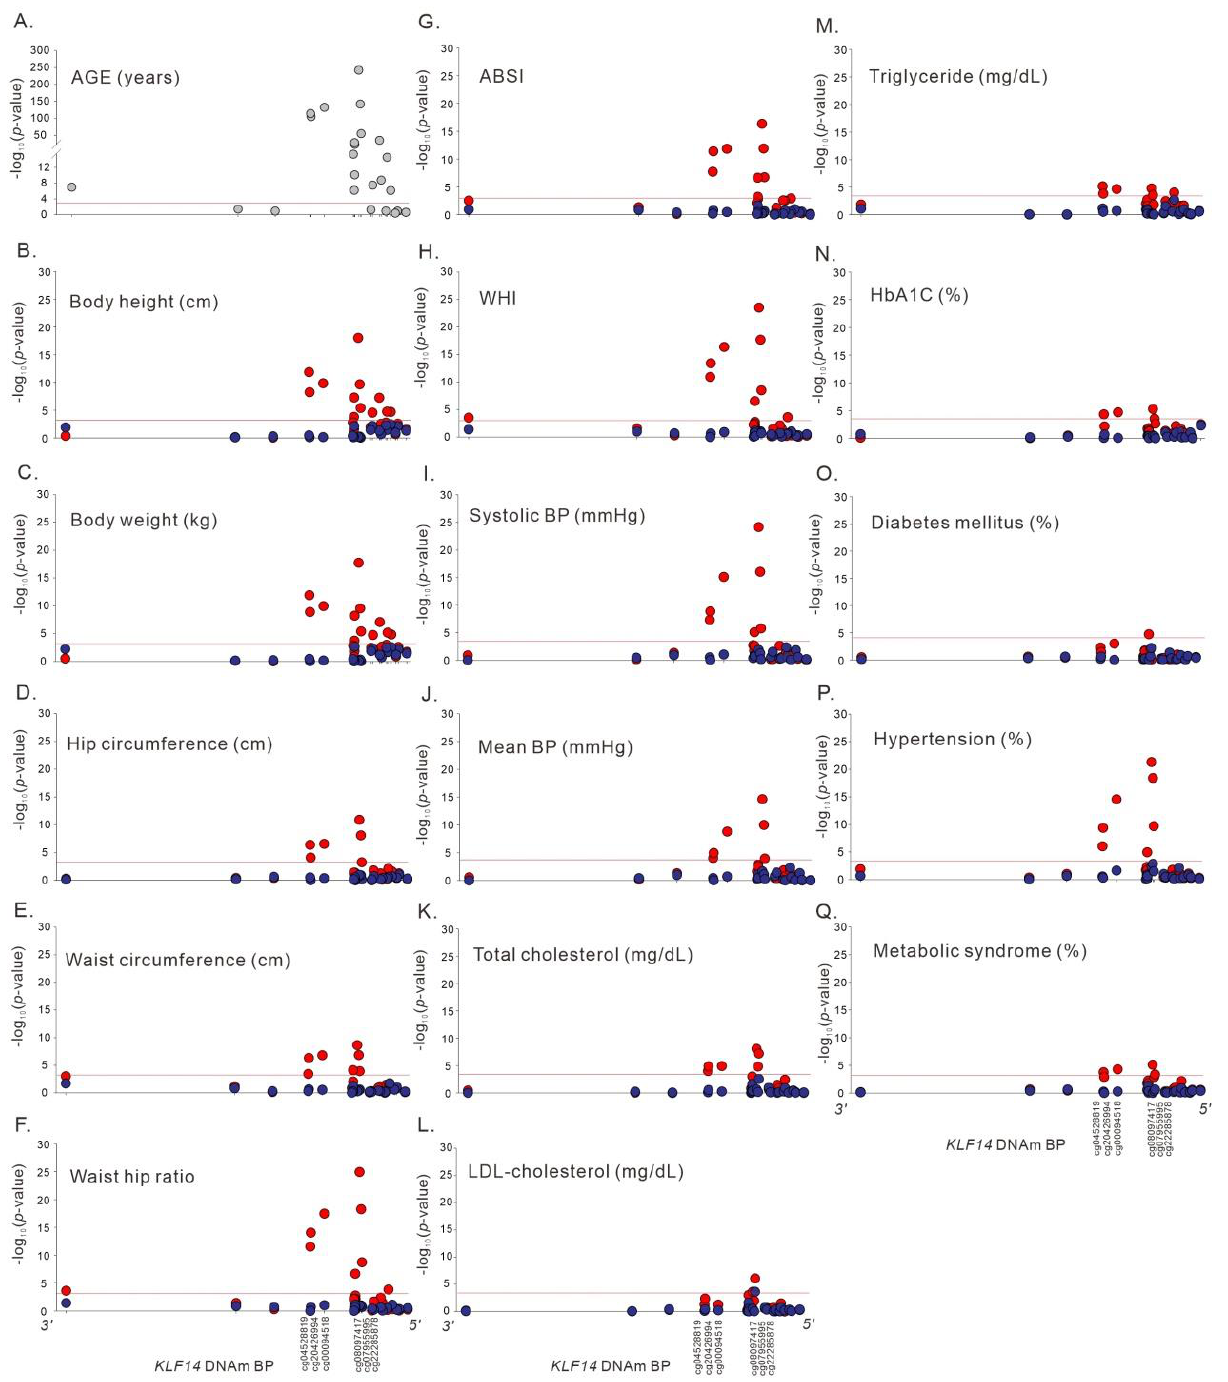
Figure 3. Regional plot association analysis between KLF14 methylation status and the studied phe- notypes ( A : Age, B : Body height, C : Body weight, D : Hip circumference, E : Waist circumference, F : Waist hip ratio, G : ABSI, H : WHI, I : Systolic BP, J : Mean BP, K : Total cholesterol, L : LDL-cholesterol, M : Triglyceride, N : HbA1c, O : Diabetes mellitus, P : Hypertension, Q : Metabolic syndrome) with (blue circle) or without (red circle) adjustment for age. The results showed subsidence of significant associations after adjustment for age.